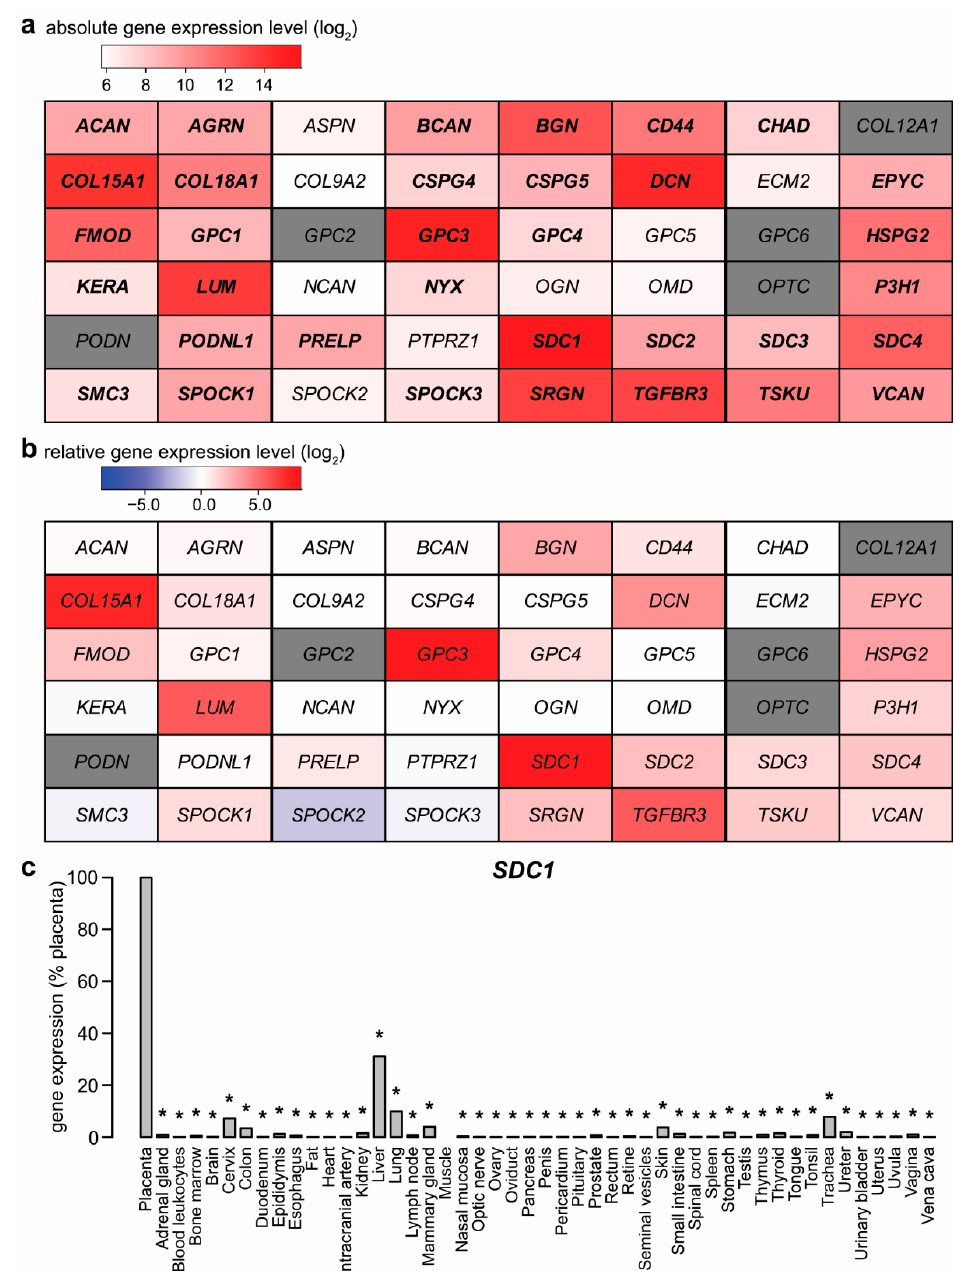
Figure 1. Placental expression of proteoglycan genes. ( a ) Absolute microarray gene expression values in the BioGPS database [49,50] were visualized on a heatmap. Color code depicts log 2 gene expression levels. Bold letter: expression above threshold 100. Grey color: no data were available. ( b ) Placental expression of proteoglycan genes was compared to the median expression of 78 other tissues or cells. Differential expression of proteoglycan genes in the placenta was visualized on a heatmap. Color code depicts log 2 gene expression ratios. Grey color: no data were available. ( c ) Real-time quantitative reverse transcription PCR (qRT-PCR) validation of BioGPS data on SDC1 expression in human tissues (n = 3) was visualized on the diagram as the percentage of placental expression. SDC1 mRNA expression values were normalized to RPLP0 . Unpaired t -test was used for the analysis of SDC1 expression profiling with the Human Major Tissue qPCR Array. (* p < 0.05). Ribosomal Protein Lateral Stalk Subunit P0— RPLP0 ; syndecan-1— SDC1 .